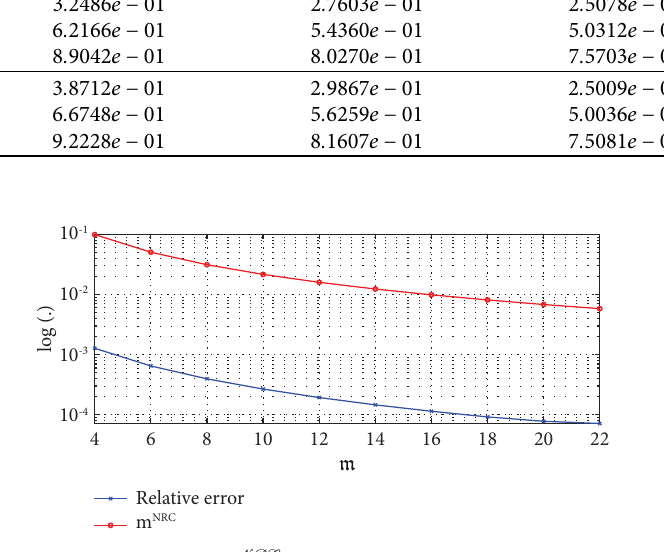
Figure 1: Relative error and m NRC (in log scale) for diferent m for Example 1.